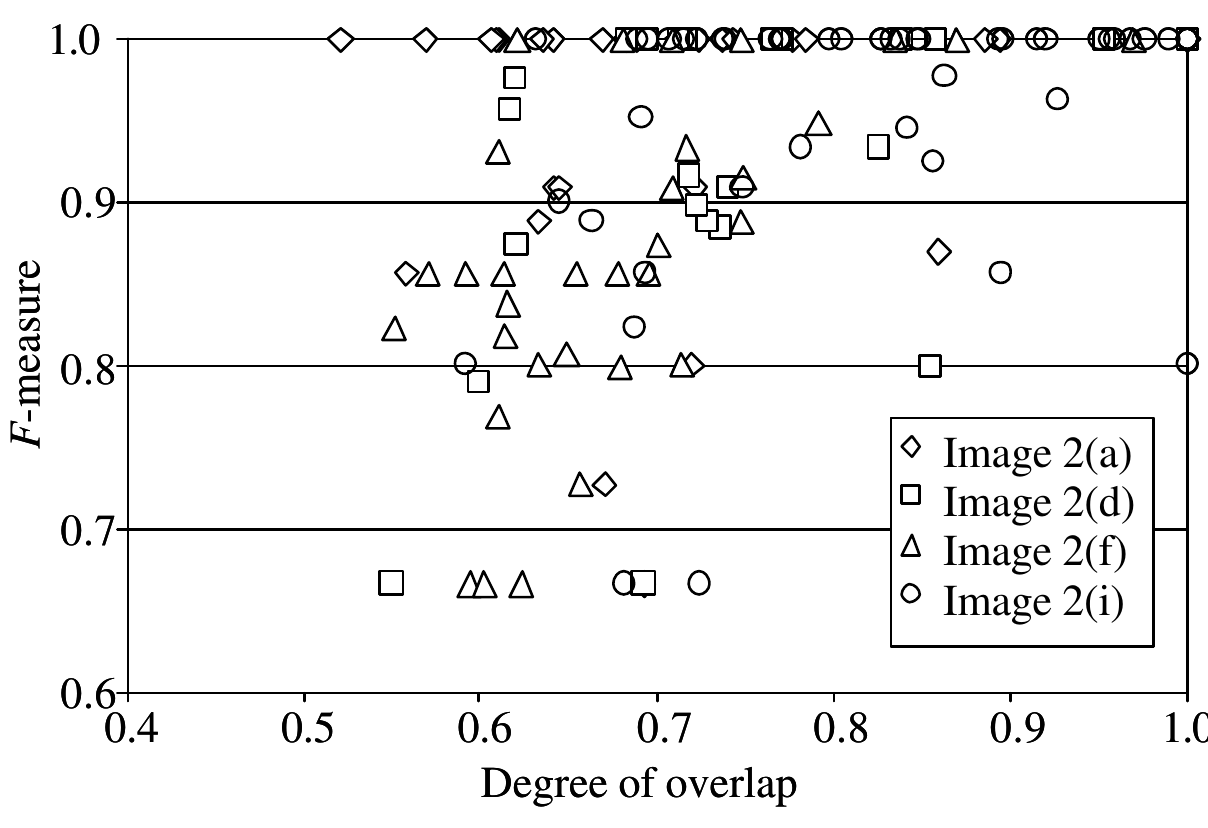
Figure 5 Scatter plot of segmentation performance against overlapping degree sample figure